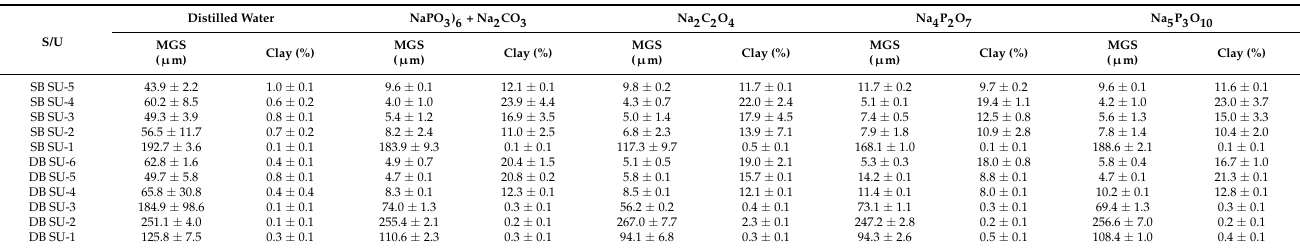
Table 3. Mean grain size (MGS) and clay content determined through the use of different dispersants for each stratigraphic unit (SU) of the Spitzbrunnen (SB) and Daschsbrunnen (DB) sites. The data of samples from each stratigraphic unit were averaged (arithmetic mean) and are given together with the standard deviation.